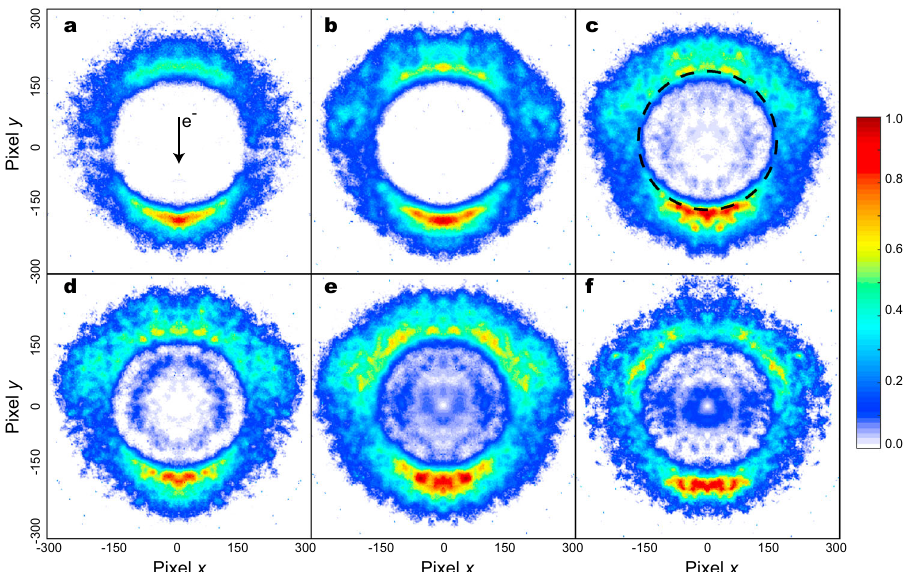
Fig. 2 Time-sliced velocity images of CN − . These CN − ions are produced in dissociative electron attachments to BrCN at the attachment energies of 3.57 ( a ), 4.57 ( b ), 5.07 ( c ), 5.27 ( d ), 6.07 ( e ), and 6.57 ( f ) eV. a The electron incident direction is denoted with an arrow in the middle of image, which de fi nes the forward- and backward-scattered distributions of CN − yields. c The internal energy of the CN − ** yields distributed in the inside region of a broken circle embedded on the image is higher than the electron autodetachment threshold. These long-lived metastable CN − ** ions are also observed in ( d – f ). The anionic intensity in each sliced image is normalized with the weighing factors of different-sized Newton spheres, and each image is plotted independently in a relative intensity